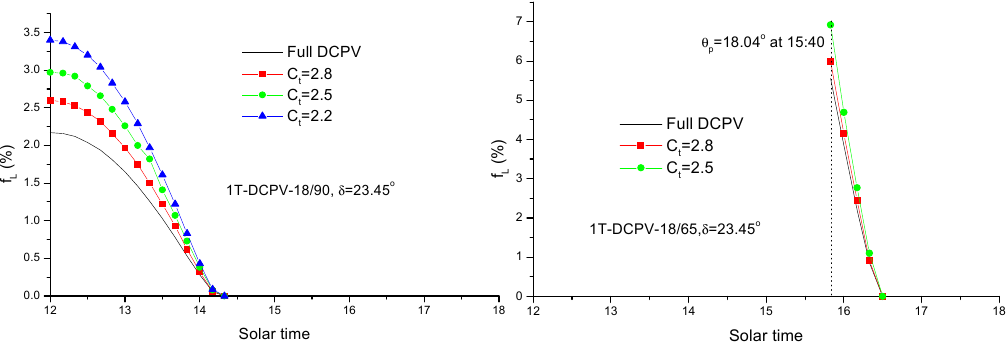
Figure 12. Solar leakage loss of 1T-DCPV-18/90 ( left ) and 1T-DCPV-18/65 ( right ) in Figure 12 . Solar leakage loss of 1T-DCPV-18/90 ( left ) and 1T-DCPV-18/65 ( right ) in solstices.